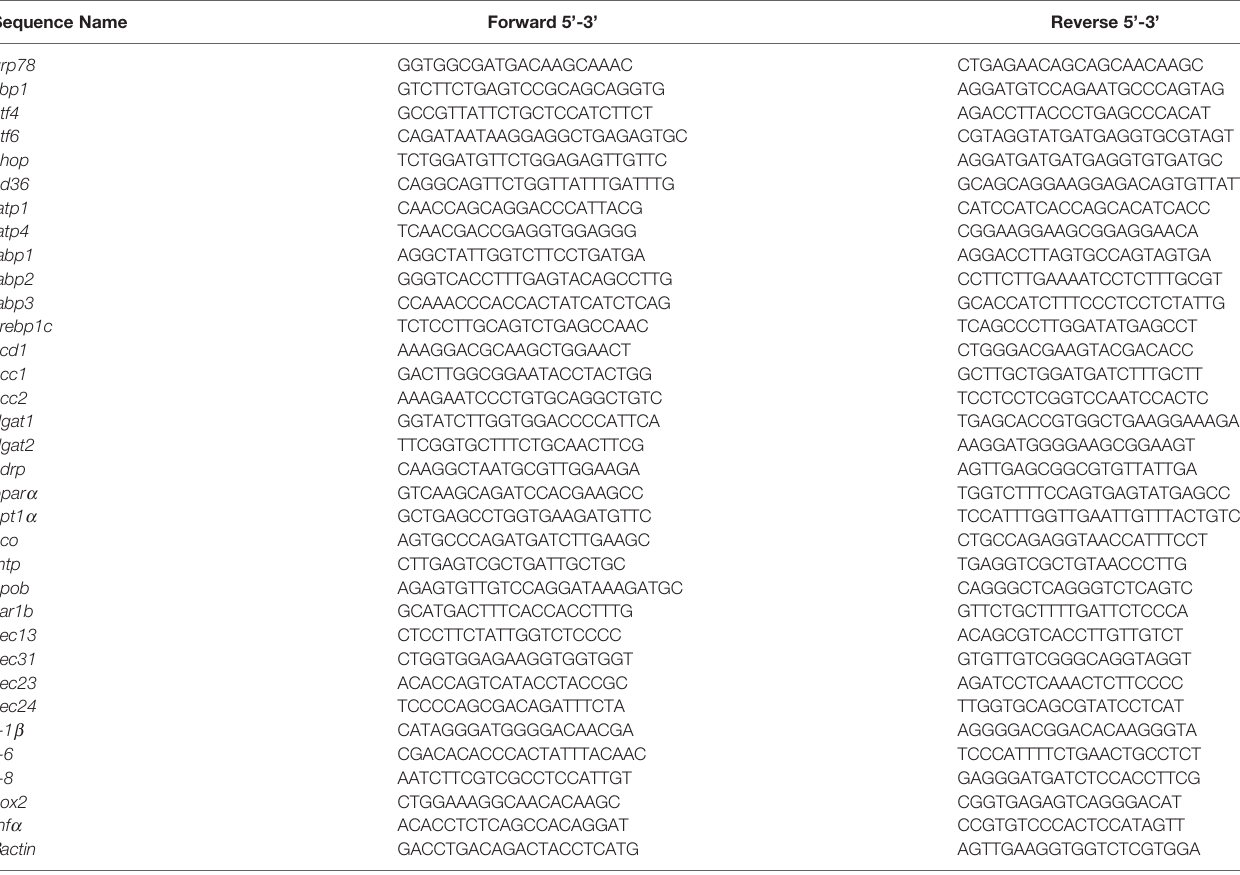
TABLE 1 | Primer sequences of genes used for quantitative real-time